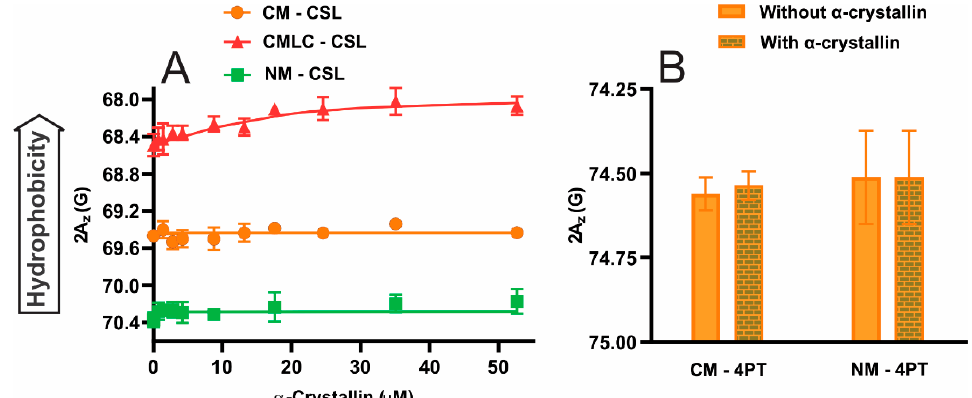
Figure 5. ( A ) Hydrophobicity (2A z ) below the surface of the bovine CM, the CMLC and the NM with the CSL spin-label within these membranes is plotted as a function of α -crystallin concentration. ( B ) Hydrophobicity on the surface of the bovine CM and NM with the 4PT spin-label is shown with 52.6 µ M α -crystallin and without α -crystallin. Figure 1 of our previous study [86] shows the method for 2A z measurement. A decrease in 2A z indicates an increase in hydrophobicity [89,94,96–98]. The hydrophobicity of the CM and NM with CSL and 4PT spin-labels does not change significantly, even with α -crystallin binding to these membranes. However, with the CSL spin-label, the hydrophobicity of the CMLC increases with increased α -crystallin concentration. This implies that decreased Chol content within the CMLC allows the binding of α‐ crystallin below the surface of this membrane, increasing the hydrophobicity below the surface of this membrane. Results are the mean ± standard deviation ( σ ) from at least three independent experiments.